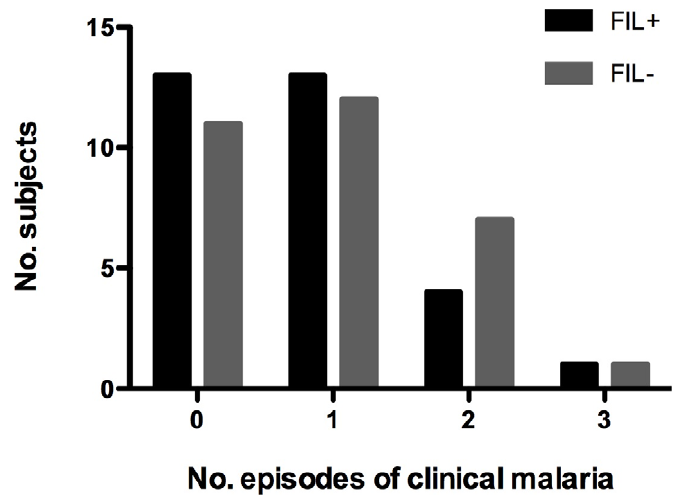
Figure 2. Incidence of clinical malaria. The bars represent the number of FIL + (black bars) and FIL 2 (gray bars) subjects who experienced 0, 1, 2 or 3 episodes of clinical malaria during the first transmission season.